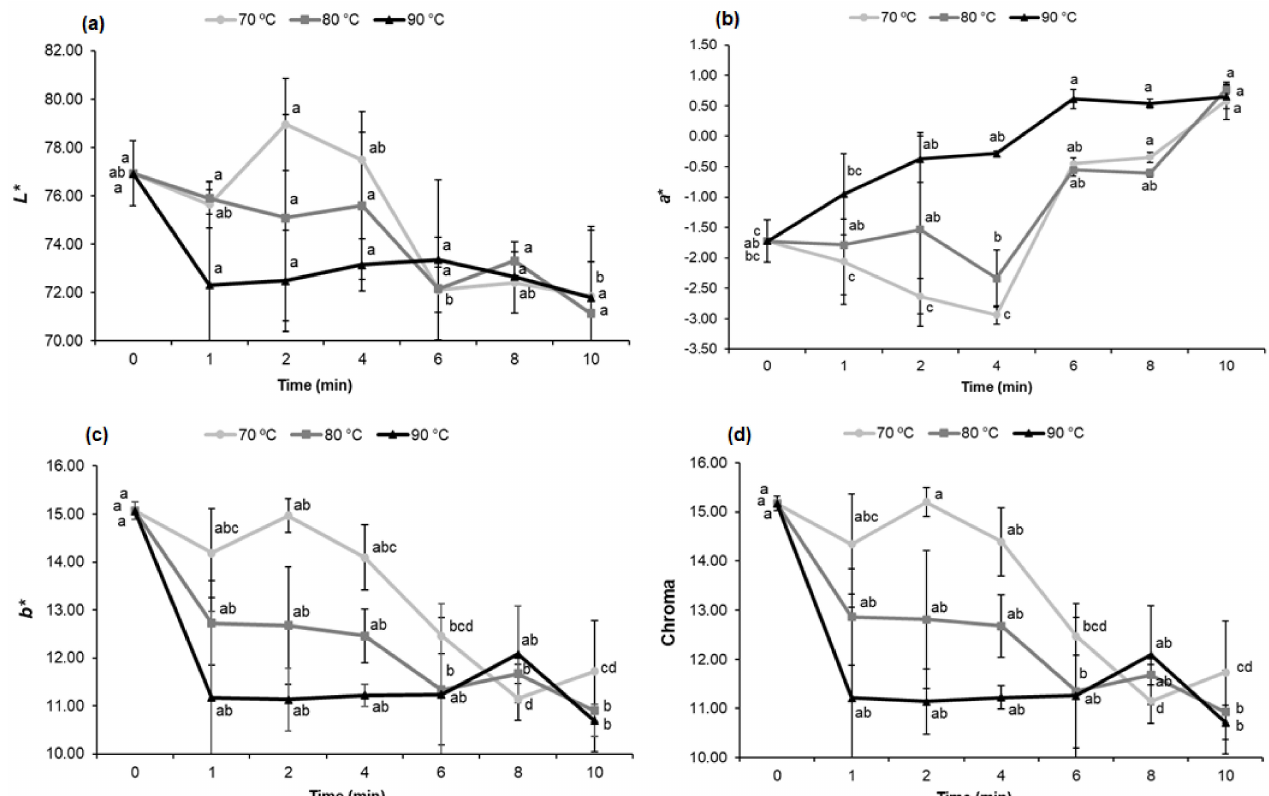
Figure 2. Effect of temperature and blanching time on color indexes ( a ) L *, ( b ) a *, ( c ) b * and ( d ) chroma of fresh cowpeas. Notes: Mean of two samples and standard deviation bar. Each sample was analyzed in triplicate. abcd Means with different letters in the same line differ significantly ( p < 0.05) according to the Tukey